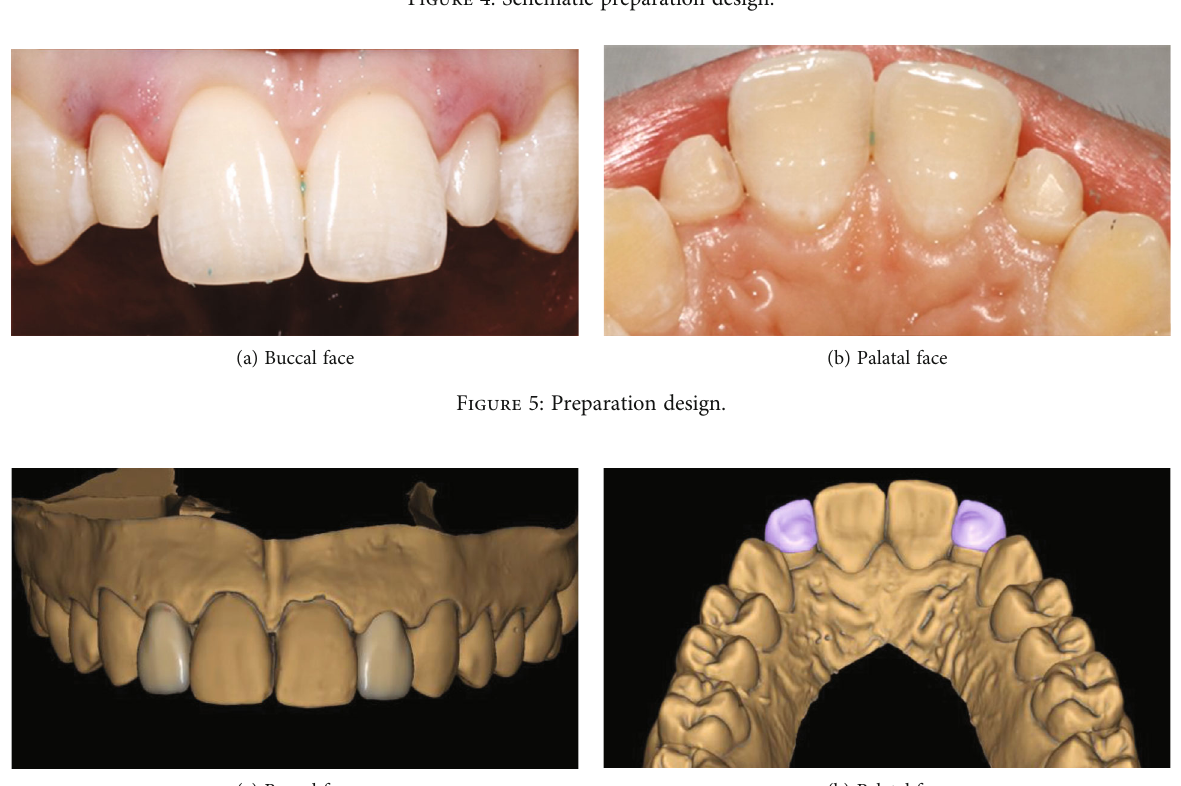
Figure 4: Schematic preparation design.